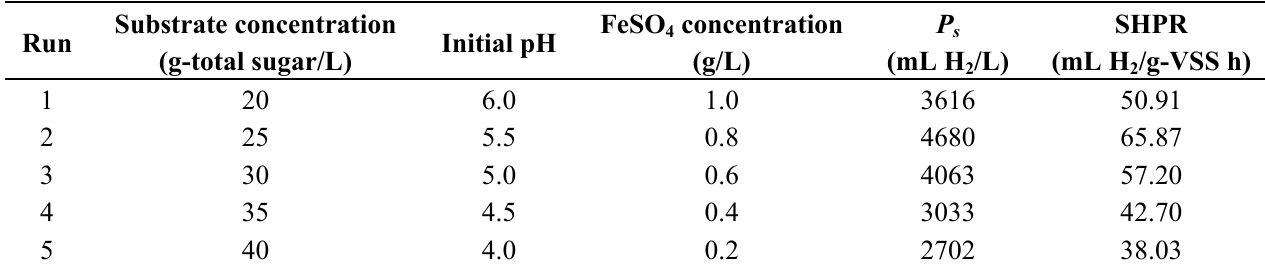
Table 2. Results and experimental design of the path of steepest